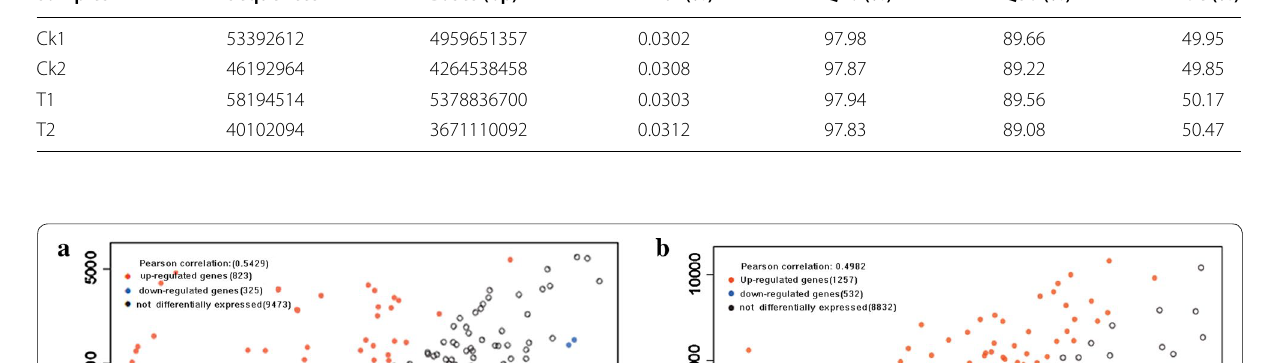
Table 2 Summary of RNA sequencing clean data Samples